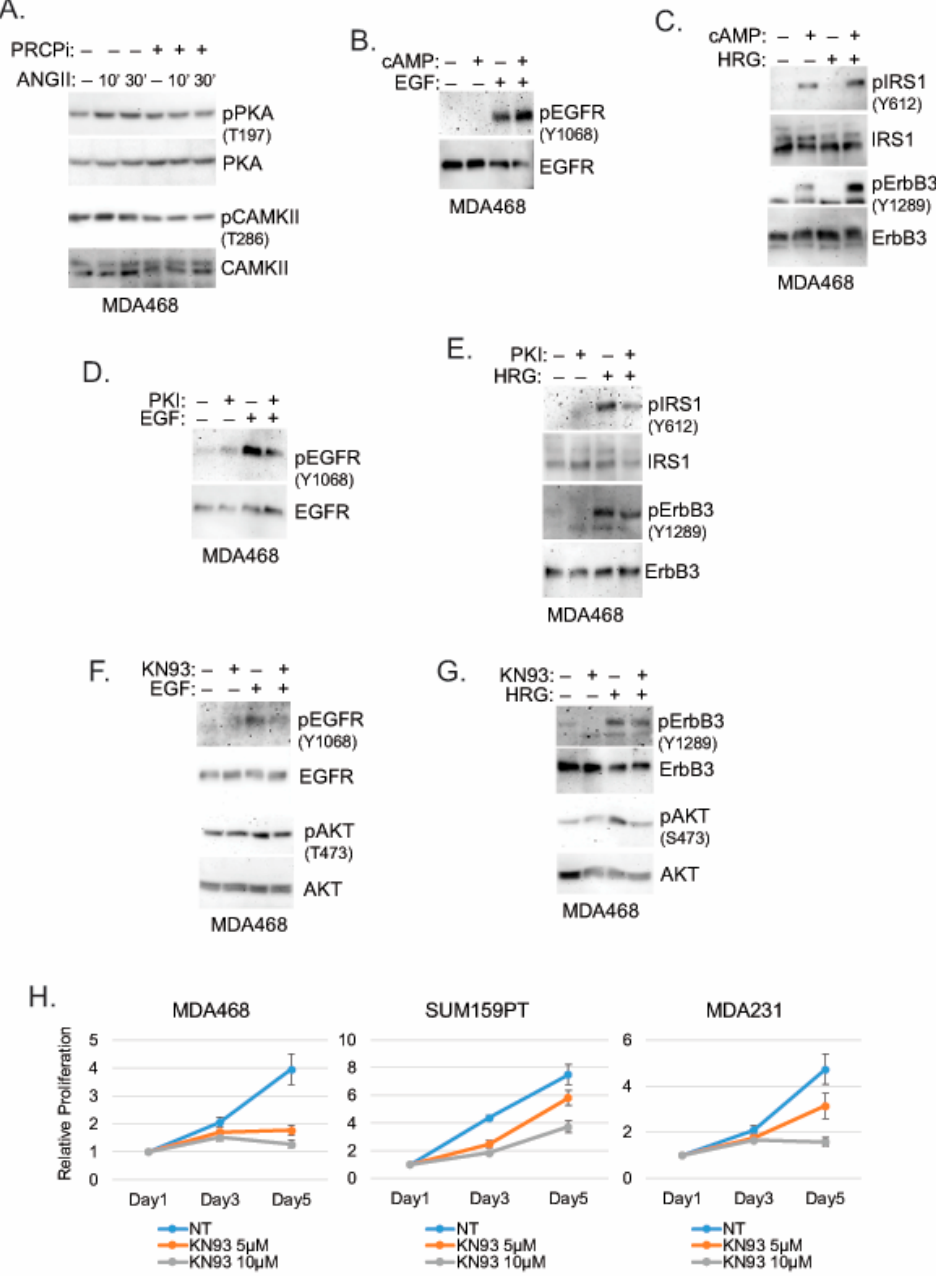
Figure 7. PRCPi suppresses PKA and CAMKII activation to decrease activation of EGFR/ErbB3 and IRS1. ( A ) MDA468 cells were serum-starved and pretreated with a vehicle or PRCPi (10 µ M) and then treated with Ang II (100 nM) for the indicated times. Serum-starved MDA468 cells were treated with cAMP and/or EGF ( B ), cAMP and/or HRG ( C ), PKI and/or EGF ( D ), PKI and/or HRG ( E ), KN93 and/or EGF ( F ), or KN93 and/or HRG ( G) for 10 min. Lysates were immunoblotted for the indicated proteins. ( H ) The indicated cell lines were cultured in the presence of the vehicle or KN93 (5 µM and 10 µM) and were harvested at the indicated times. Relative cell proliferation was analyzed with Hoechst staining of cellular DNA. Average (8 replicate) relative fluorescence intensity of Hoechst is presented with SD indicated. There is significant differences ( p = 0.000) between the vehicle and 10 µ M KN93 conditions in all cell lines. There is a significant difference ( p = 0.000) between the vehicle and 5 µ M KN93 in MDA468 cells. There are no significant differences ( p > 0.1) between the vehicle and 5 µ M KN93 conditions in SUM159PT and MDA231 cells. Original Western Blots and densitometry can be found at Figures